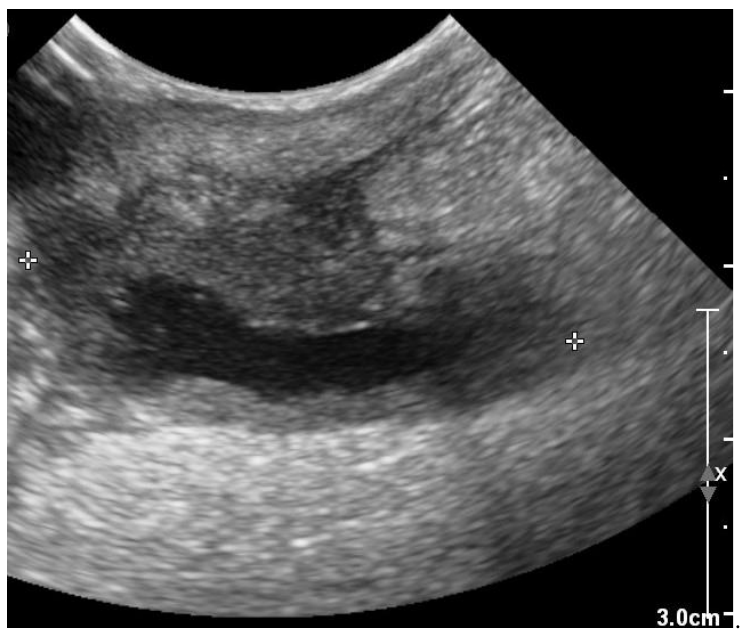
Figure 7. Two-dimensional grayscale ultrasonographic image of the swelling at the level of the previously healed surgical wound at the level of the jugular venous incision shows a pocket of fluid accumulation surrounded by abnormal soft tissue.